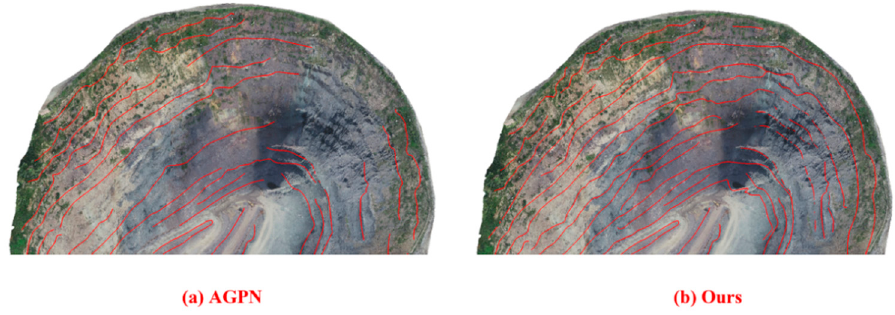
Figure 19. Step-feature lines in the cliff area: ( a ) extraction result of AGPN method; ( b ) extraction result of EDEG-CS method.